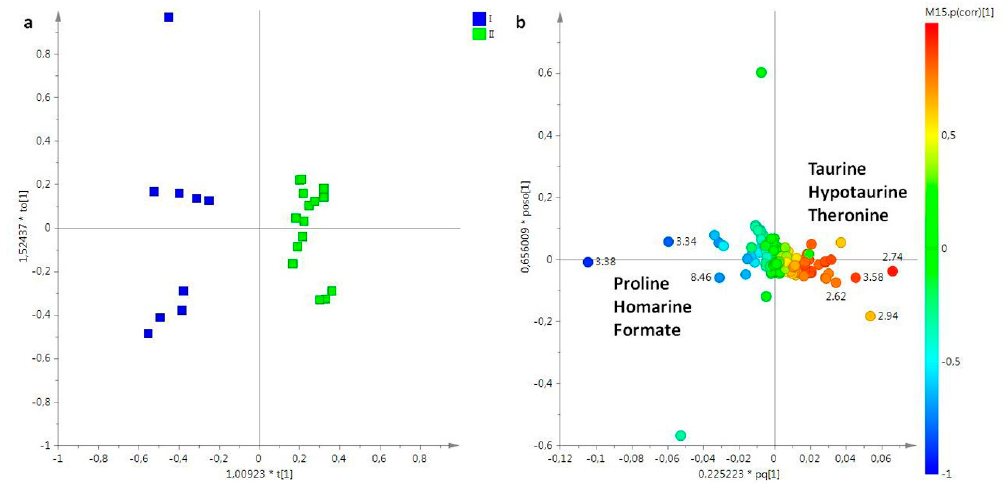
Figure 9. ( a ) OPLS-DA t[1] / t[2] scores plot of for aqueous extracts of oral arms of R. pulmo collected in di ff erent sampling periods: blue box, March sampling (I); green box May sampling (II). ( b ) Loading plot for the model; the variables indicated ppm in the 1 H NMR